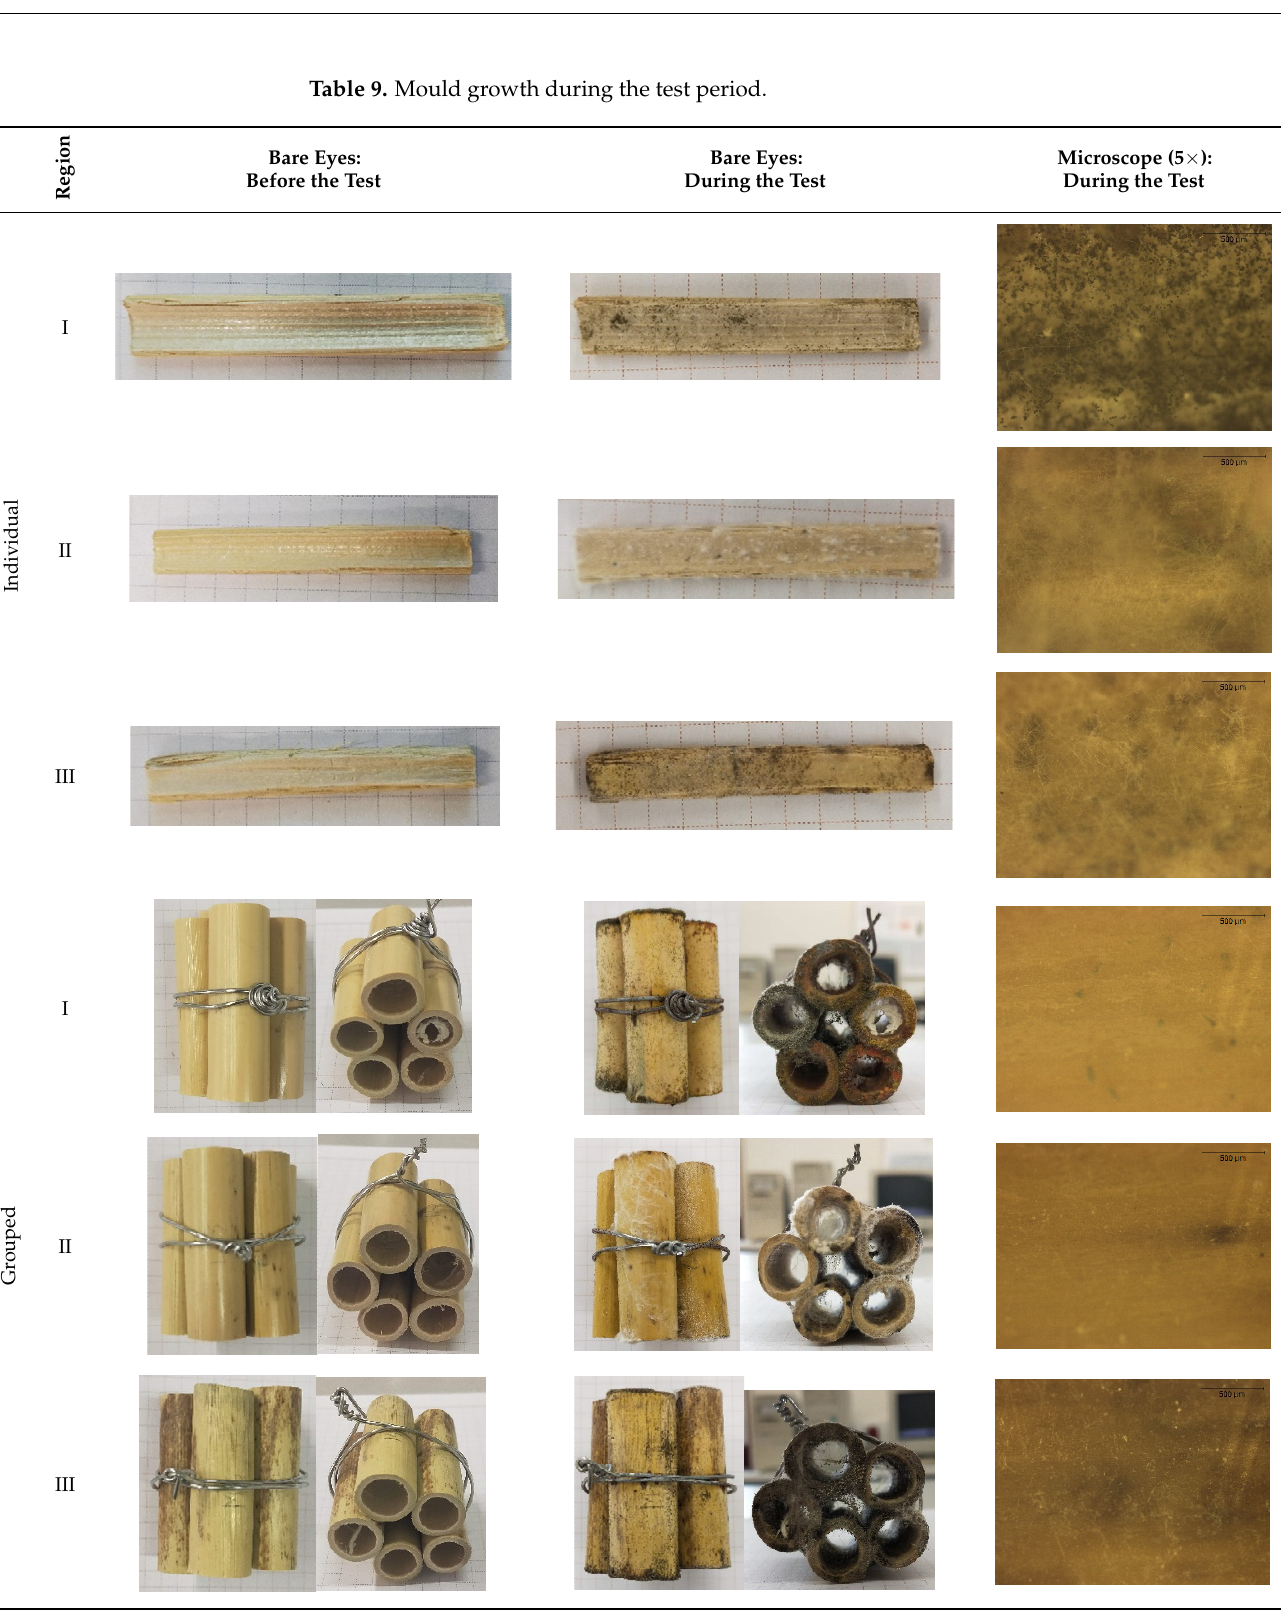
Table 9. Mould growth during the test period.